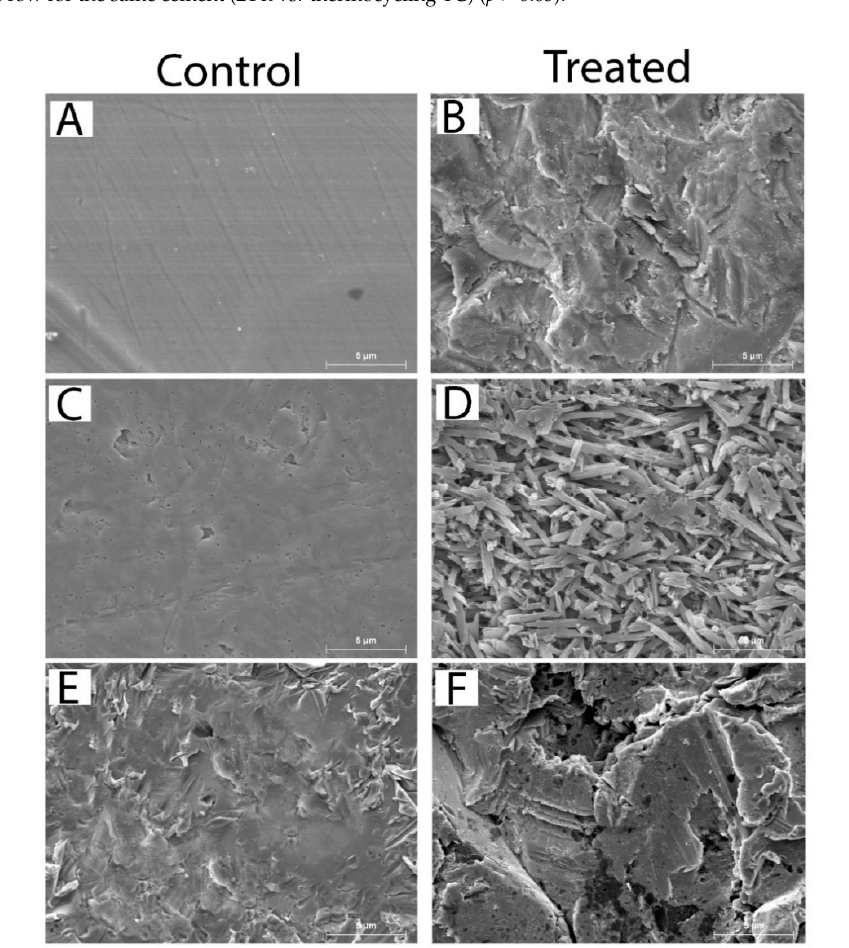
Figure 2. SEM micrographs of the bonding substrates (KAT: zirconia; LD: Lithium disilicate; AU: gold alloy) before and after surface pretreatment. Smooth and flat surface of the KAT after polishing ( A ), and after sandblasting ( B ). LD before surface treatment ( C ), and sandblasting followed by etching using hydrofluoric acid at 9.6% ( D ). Lithium crystals and the presence of microretentions within such a mineral network could be observed ( D ). AU surface after polishing with the SiC carbide paper ( E ). After sandblasting procedures there was a clear increase in roughness and microretentions ( F ).